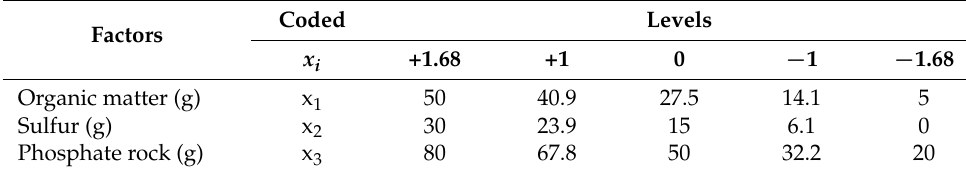
Table 1. The ranges of experimental values of the variables included in